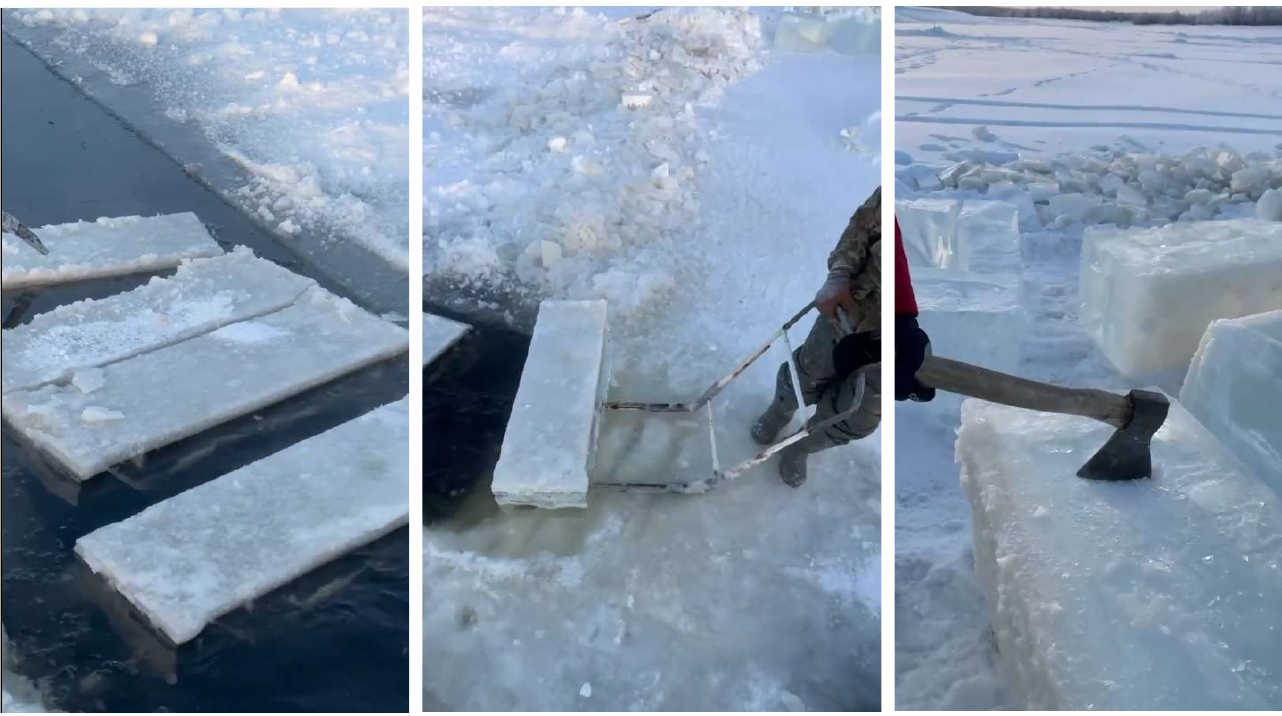
Figure 2. Preparing ice for drinking water (and food preservation) in the YNAO in winter.